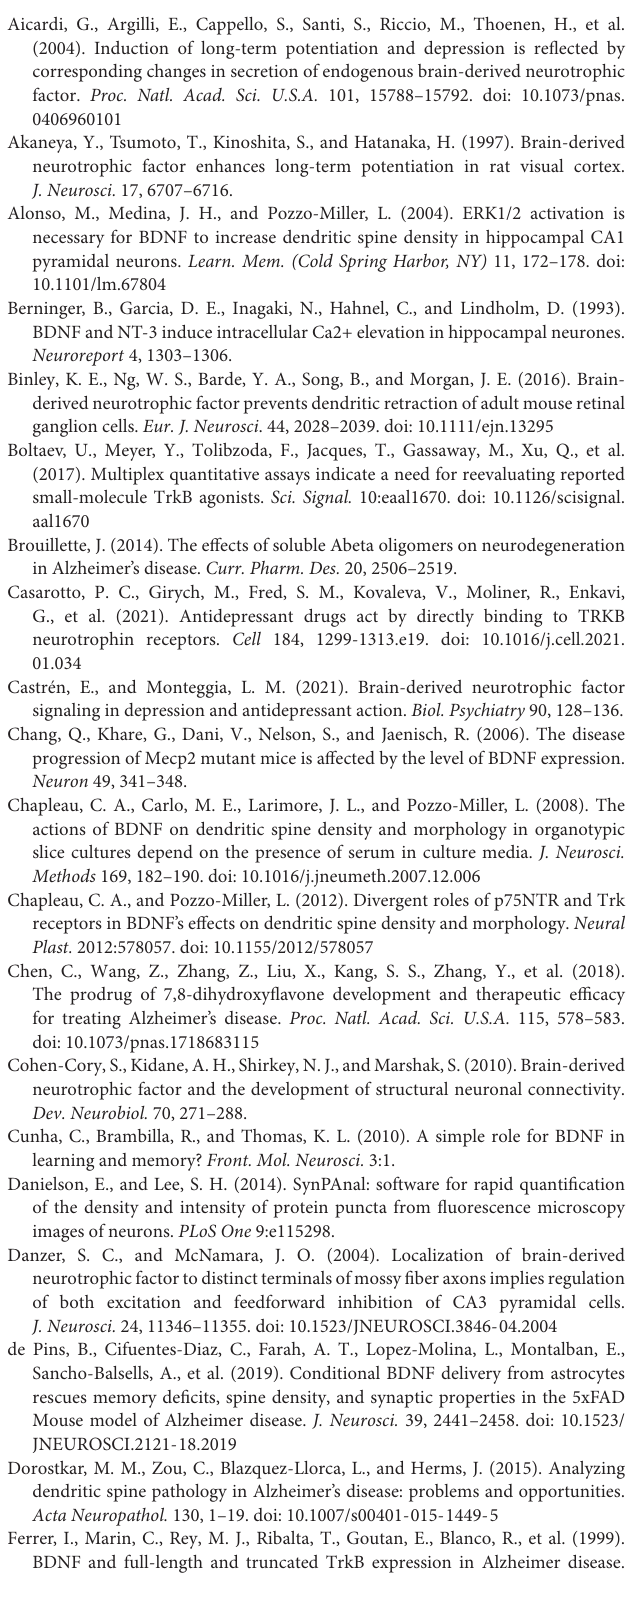
Frontiers in Molecular Neuroscience |